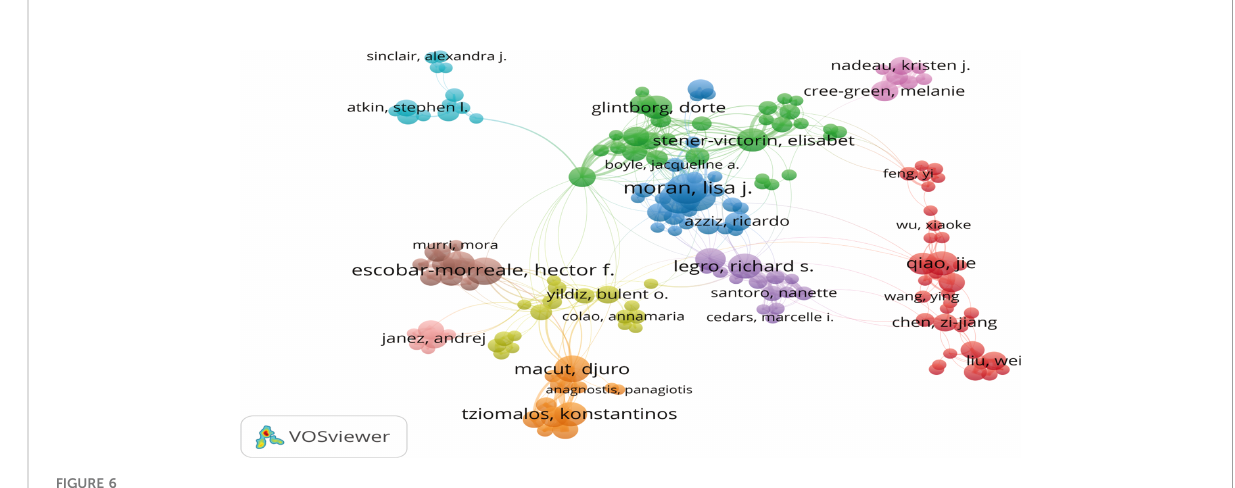
FIGURE 6 Network map of the top 150